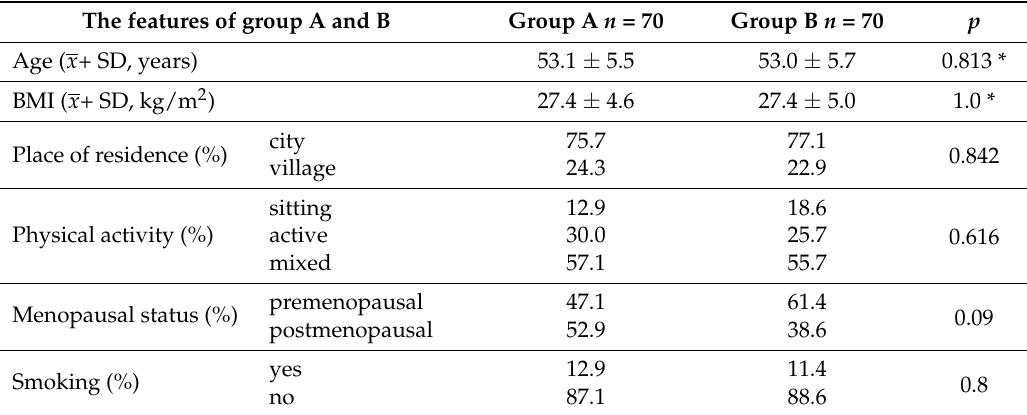
Table 1. The features of Groups A and